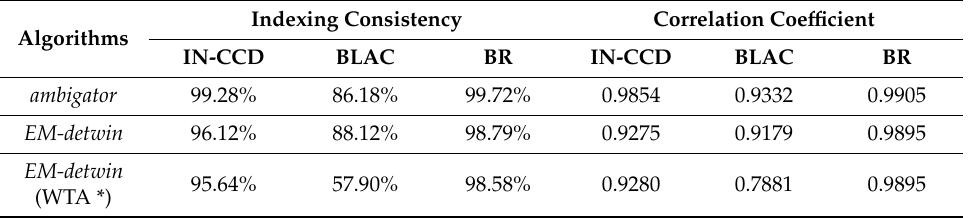
Table 6. Performance of the detwinning algorithms for reduced datasets.